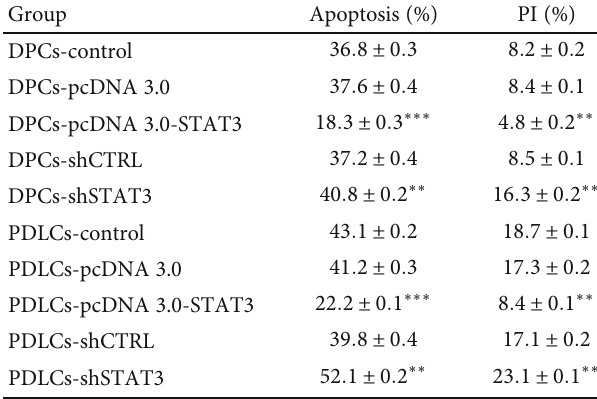
Table 6: Apoptosis and cell cycle of PDCs and PDLCs in overexpression and silence models ( mean ± SD % ; N = 3 ).